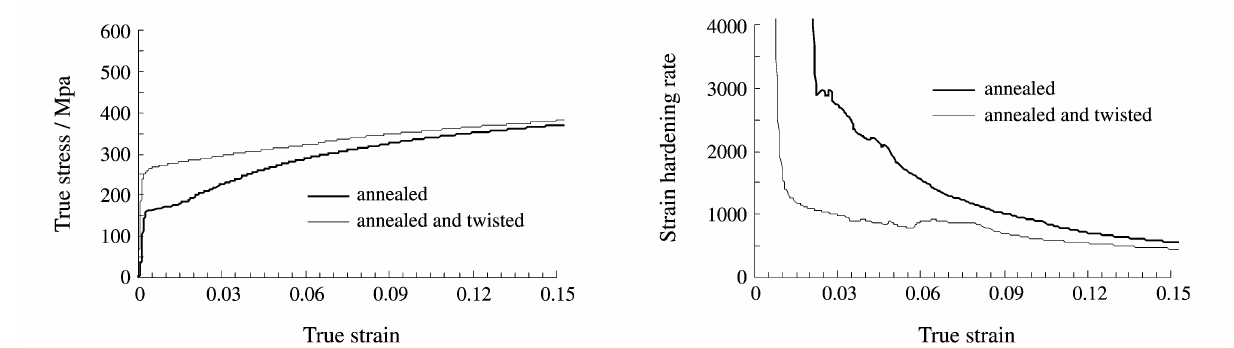
Figure 1. Effect of cyclic torsion on the hardening behavior of annealed